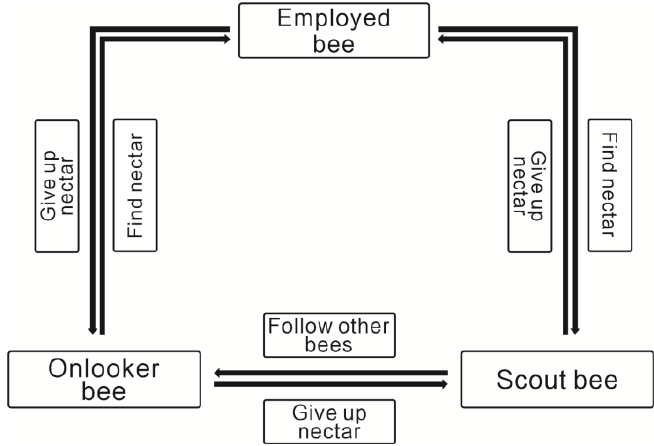
Figure 1. Structure Diagram of Artificial Bee colony Algorithm.